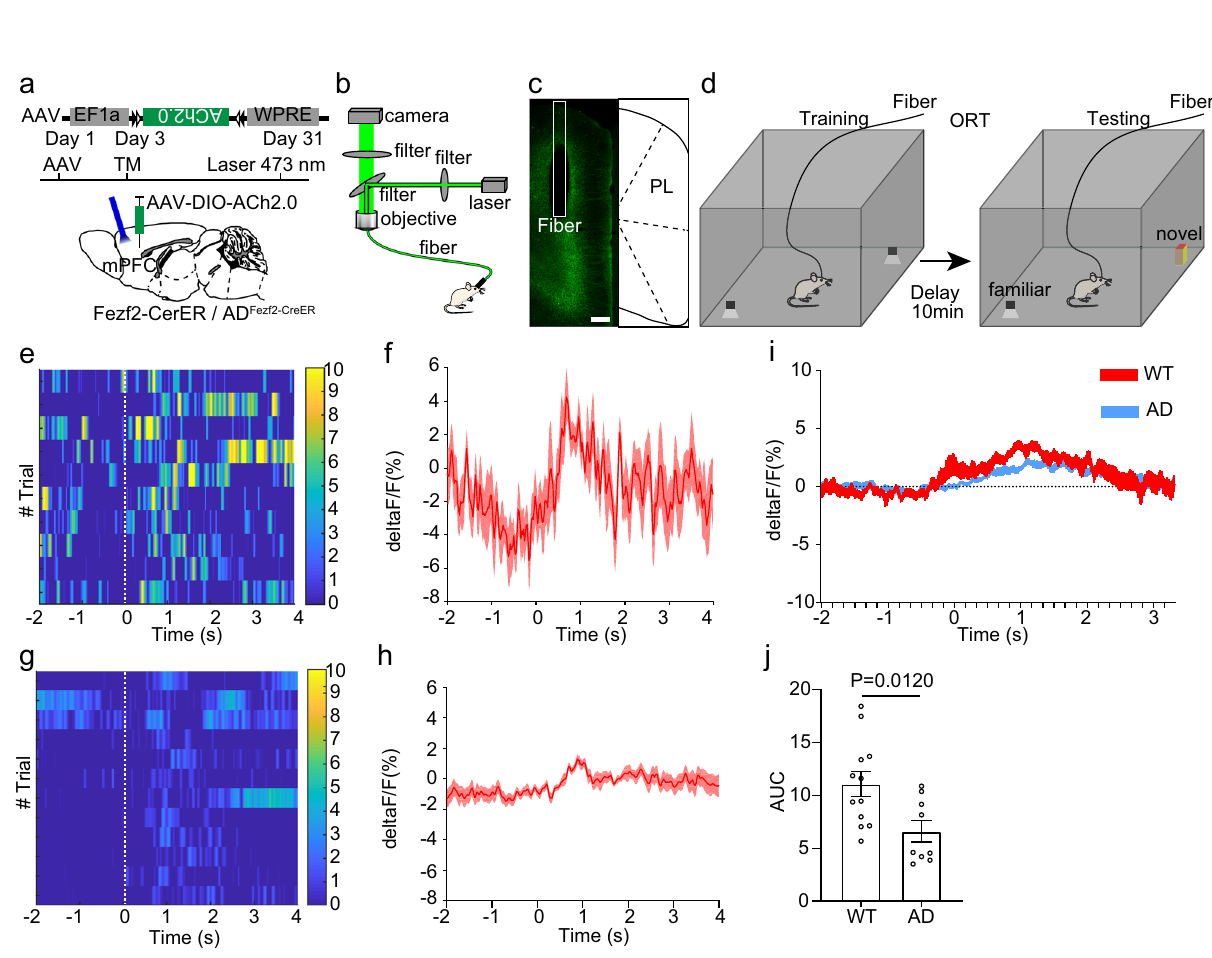
Fig. 6 Functional acetylcholine de fi ciency to extratelencephalic projection neurons in the mPFC of 5×FAD mice. a Expressing the acetylcholine indicators in Fezf2 positive neurons in the mPFC with a Cre dependent virus. The Cre expression was induced by tamoxifen 3 days after the virus injection. b The scheme of fi ber photometry. c The expression of acetylcholine indicators in Fezf2 positive neurons in the mPFC. d The experimental design of object recognition test. e Heatmap of acetylcholine response of extratelencephalic projection neurons in the PL of Fezf2-CreER mice during object interactions. f Average plots across different trials of individual animals of acetylcholine response of extratelencephalic projection neurons in PL of Fezf2-CreER mice during object interactions. g Heatmap of acetylcholine response of extratelencephalic projection neurons in PL of AD Fezf2-CreER mice during object interactions. h Average plots across different trials of individual animals of acetylcholine response of extratelencephalic projection neurons in PL of AD Fezf2- CreER mice during object interactions. i Average plots of acetylcholine response of extratelencephalic projection neurons in the PL of both Fezf2-CreER mice and AD Fezf2-CreER mice during multiple tests on multiple animals (Fezf2-CreER, n = 12 animals; AD Fezf2-CreER mice, n = 9 animals). j The quanti fi cation of AUC in i The acetylcholine response of extratelencephalic projection neurons in PL of both Fezf2-CreER mice is stronger than that in AD Fezf2-CreER mice. (Two-tailed Mann-Whitney test, Fezf2-CreER mice, n = 12 animals; AD Fezf2-CreER mice, n = 9 animals.) Scale bar in c is 200 μ m. ACA anterior cingulate area, PL prelimbic area, TM tamoxifen. All data are listed as the Mean ± SEM. The color bars in the fi gure indicated df/f (%).